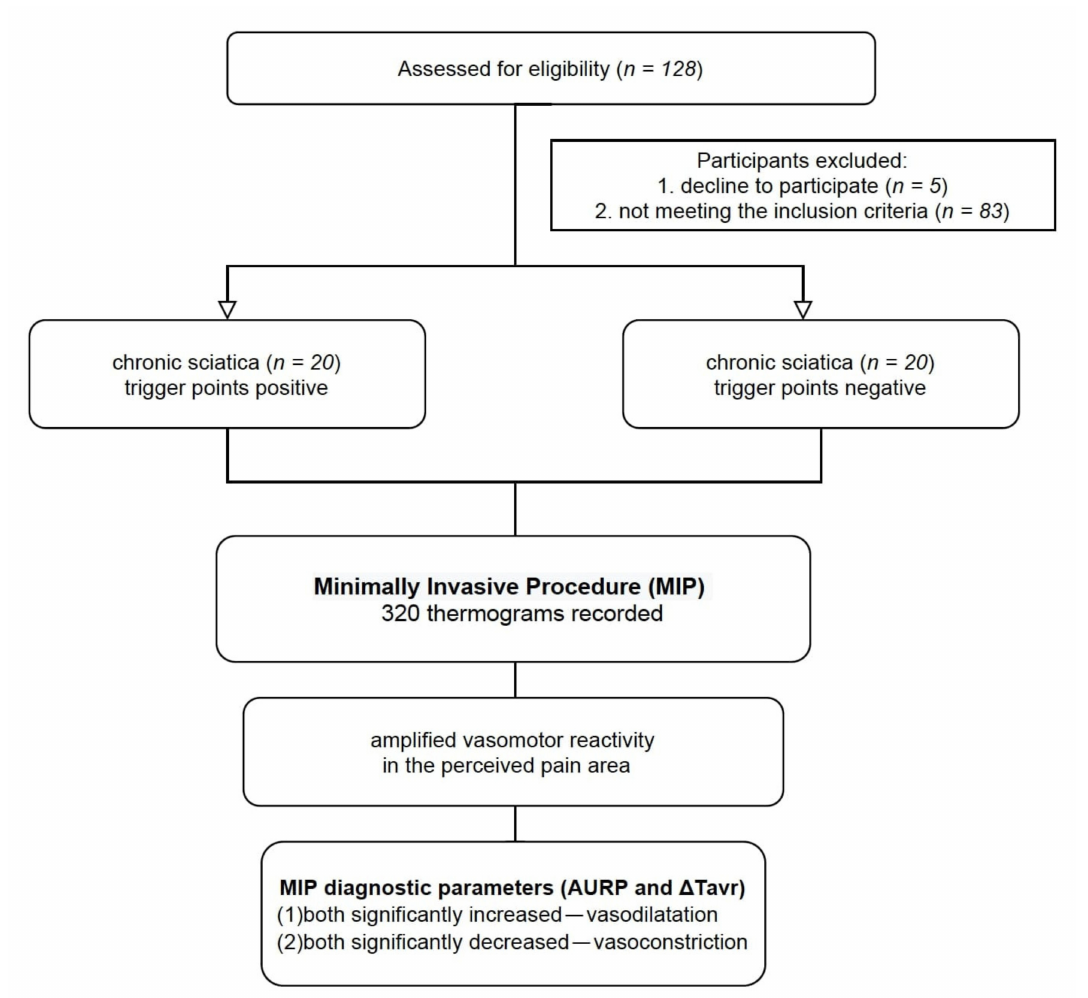
Figure 1. A flow diagram of the study